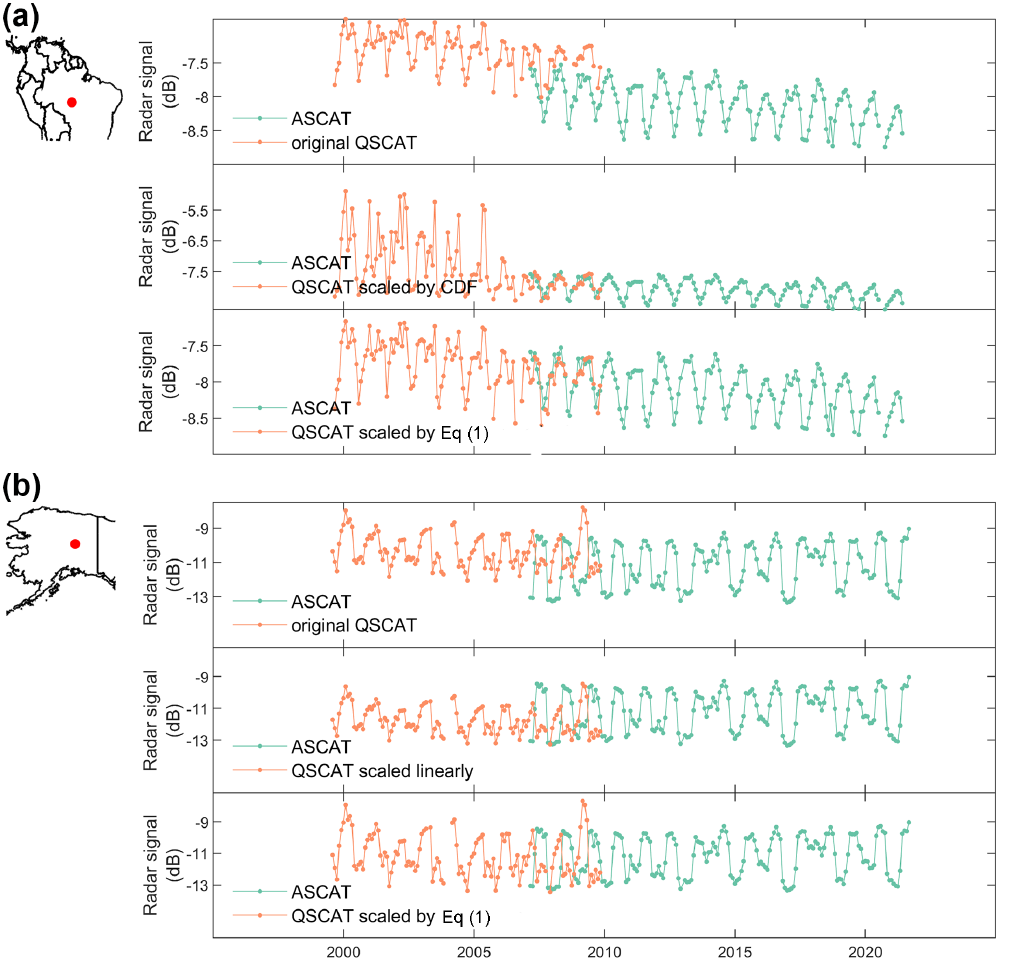
Figure 3. Comparisons between the CDF method, the linear regression correction, and the method illustrated in Eq. (1) for rescaling radar signals. In most regions, the three methods performed almost equally well (Fig. S1), but the CDF method and the linear regression correction failed for signals with a strong trend or sudden changes. (a) Comparison between the CDF method and the method shown in Eq. (1) for rescaling a QSCAT signal time series with a strong decreasing trend. (b) Comparison between the linear regression correction and the method shown in Eq. (1) for rescaling a QSCAT signal time series with sudden increases in signal during the overlapping